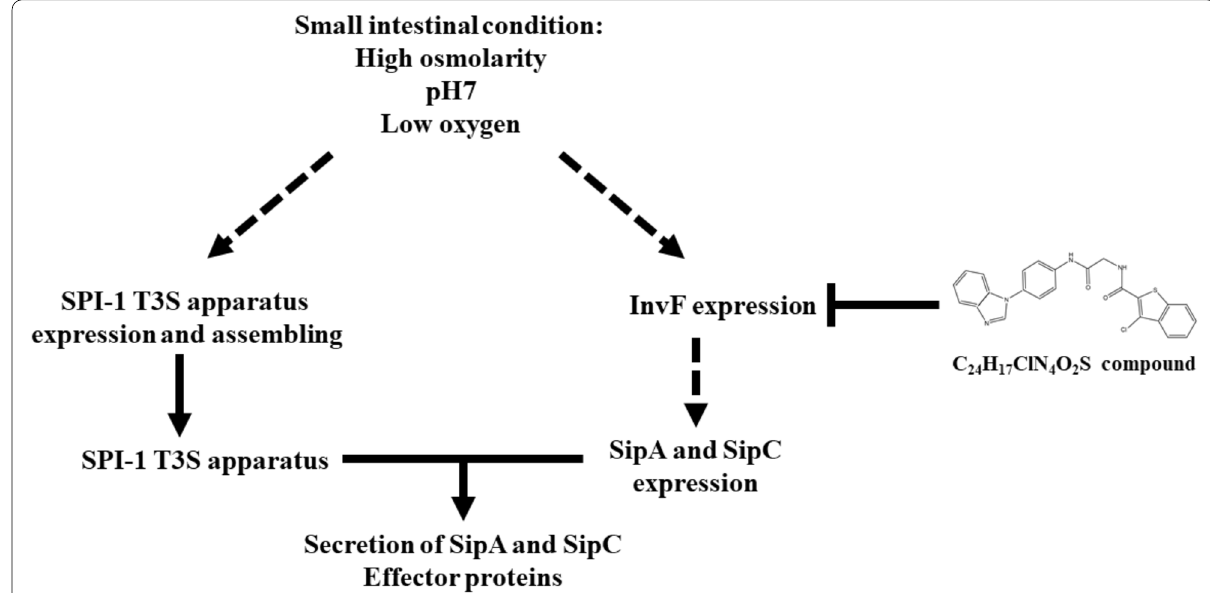
Fig. 5 The proposed inhibition pathways of C 24 H 17 ClN 4 O 2 S compound on secretion of SPI-1 effector proteins. The dotted line arrow indicated transcription activation. The blunt ended line indicated